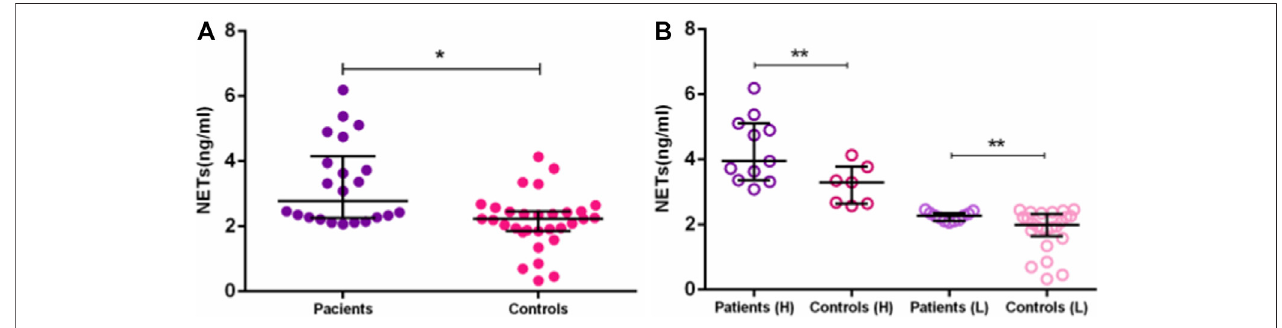
FIGURE 2 | NETs concentration between AD patients and controls. Differences in NETs concentration between: (A) — AD patients and elderly controls. (B) — AD patients and elderly controls in High (H) and Low (L) groups. * p ≤ 0.01; ** p ≤